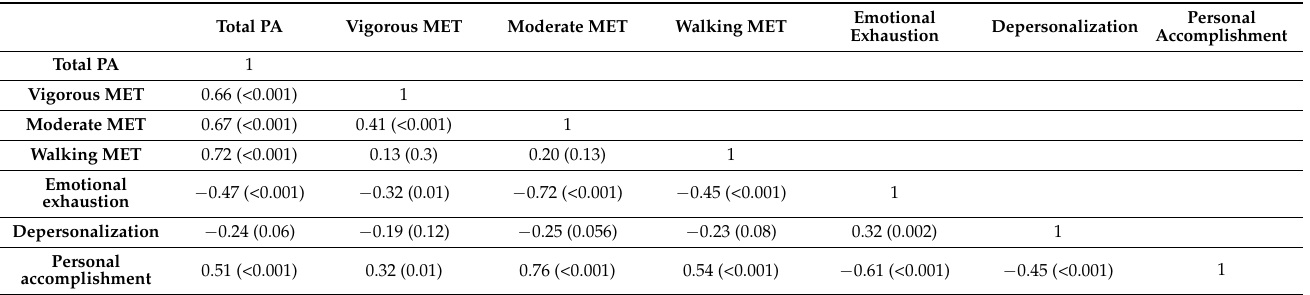
Table 3. Correlations between physical activity (PA) levels and burnout subscales among participants during